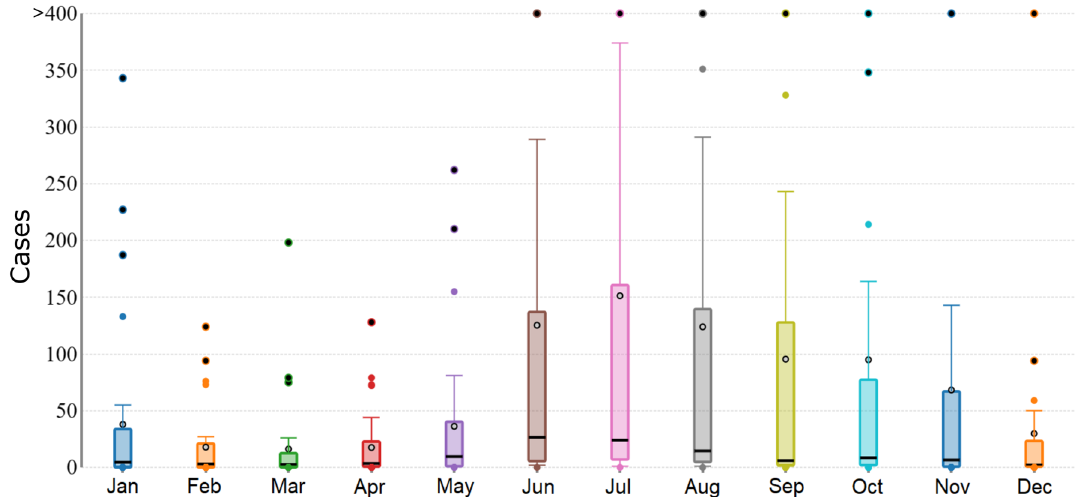
Figure 2. Monthly distribution of total malaria cases in Lunglei, Serchhip, and Mamit districts of Mizoram